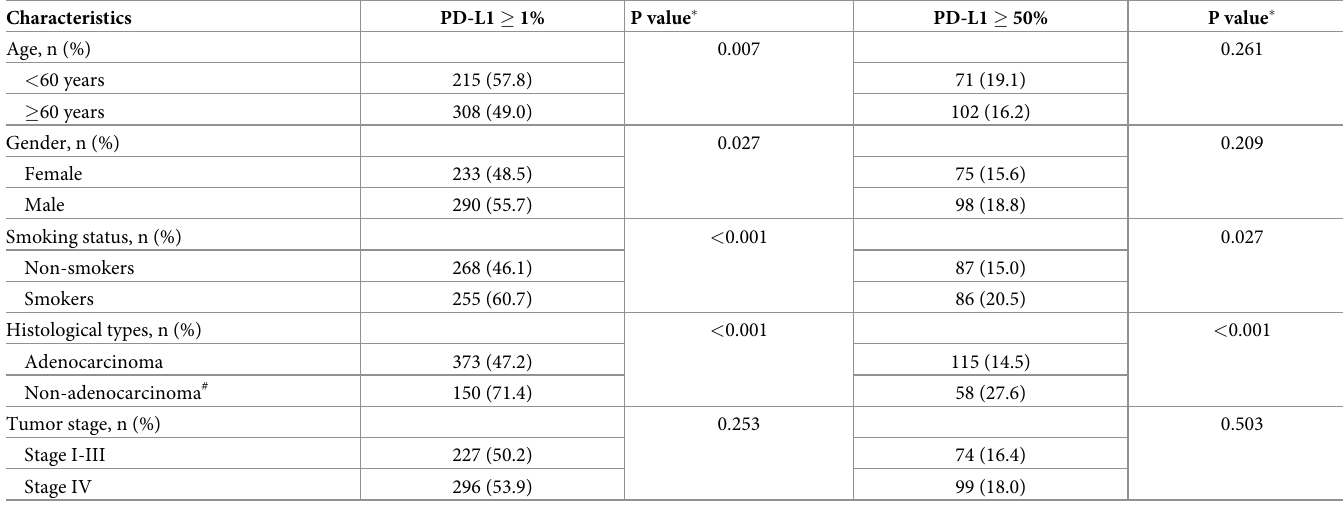
Table 2. Univariate analysis of patient’s characteristics and PD-L1